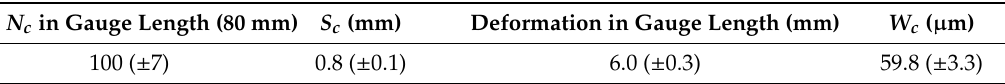
Figure 7. Single fiber pullout load and pullout distance curves of specimens (Different colors of lines indicate different samples with identical mixture.).